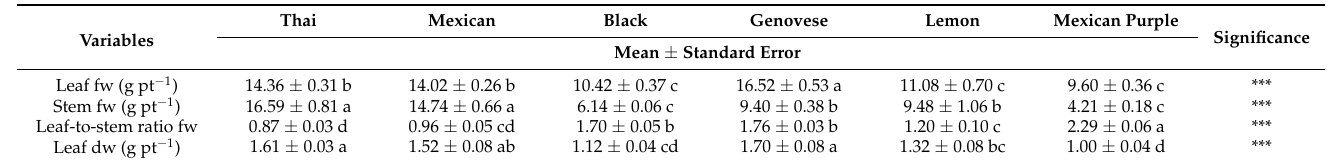
Table 1. Comparison of Thai, Mexican, Black, Genovese, Lemon, and Mexican Purple basil on biometric